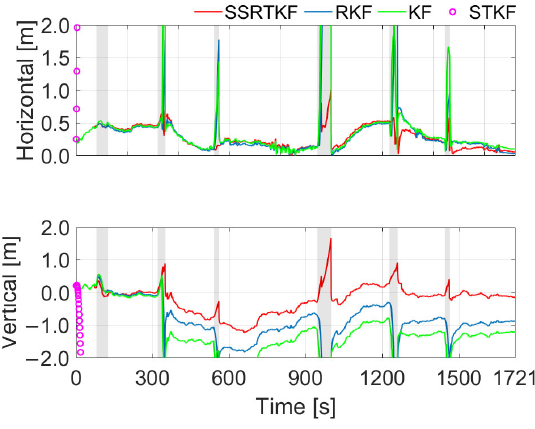
Figure 9. Positioning errors of the three filters. Table 2. Three simulation schemes to analyze the impacts of the urban environment. The LOS Multipath